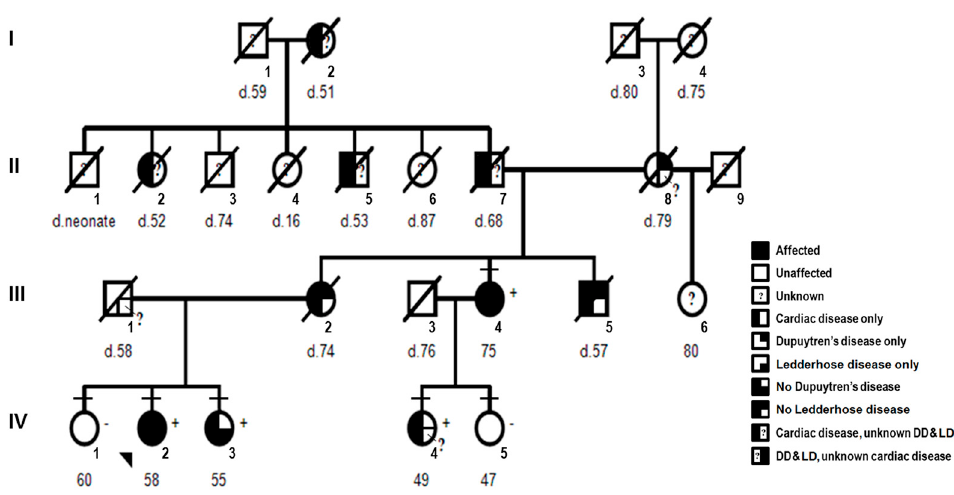
Figure 1. Pedigree: LMNA -related cardiac disease, Dupuytren’s disease (DD), and Ledderhose disease (LD). Squares denote males and circles females with current age below. Short horizontal lines mark individuals consented in the study. Diagonal lines indicate deceased individuals with age of death (d). The proband (IV-2) is designated with an arrow. Complete-filled symbols indicate cardiac disease (cardiomyopathy, arrhythmia or sudden death), Dupuytren’s disease, and Ledderhose disease. Left half-filled indicate only cardiac disease and right half-filled symbols indicate only Dupuytren’s disease (upper right) or only Ledderhose disease (lower right). Individuals with unknown or unconfirmed clinical status are noted with a question mark. The presence (+) or absence ( − ) of the LMNA c.736C>T (p.Gln246Stop) is provided. One additional family member (Patient 3) was removed